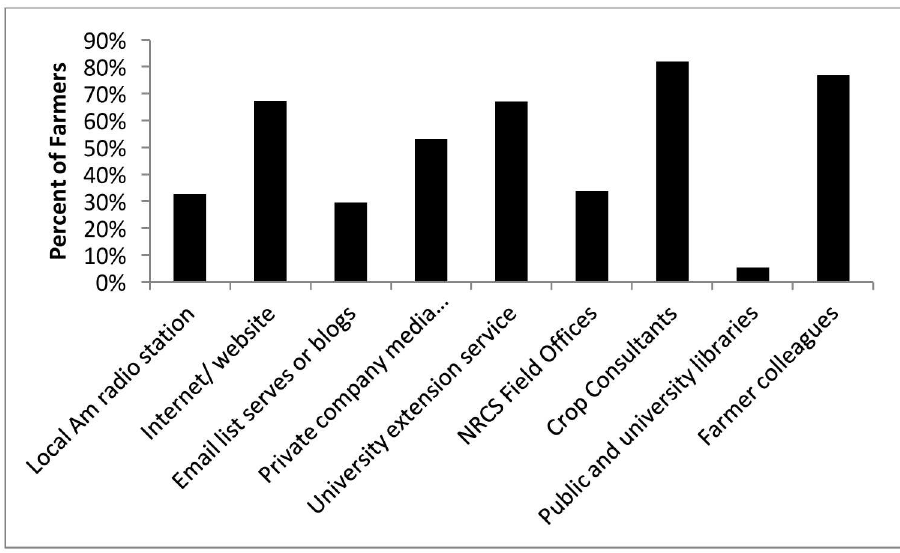
Fig 5. Percentage of farmerswho indicated each information source was in their top five most used